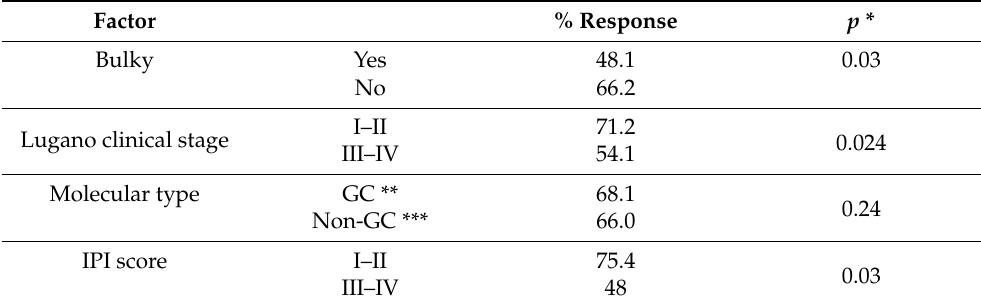
Table 3. Bivariate analysis of factors influencing clinical response. Factor